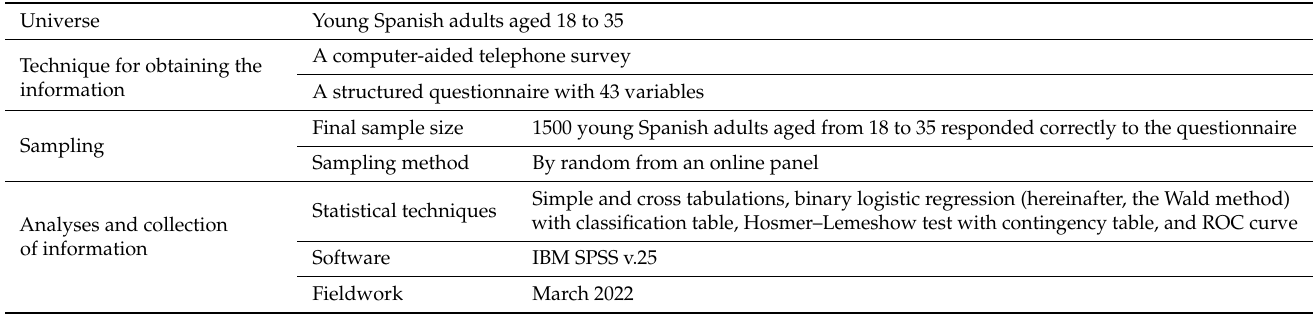
Table 1. Quantitative study fact